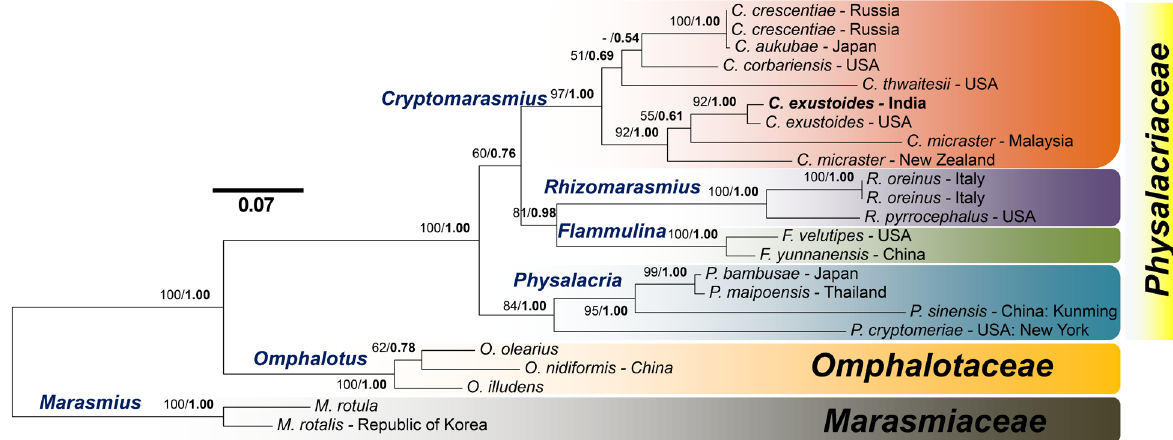
Figure 2. Maximum likelihood (ML) tree generated using combined datasets of nrITS and nrLSU sequences by employing GTR+I+G model of nucleotide evolution (- lnL = 9264.444470). Numbers to the left of / are ML bootstrap support, and those to the right indicate the Bayesian posterior probabilities (PP). ML >50% and PP > 0.50 values are indicated below or above the branches and the scale bar represents the expected changes per site. The Indian collection of Cryptomarasmius exustoides is placed in bold font to highlight its phylogenetic position in the